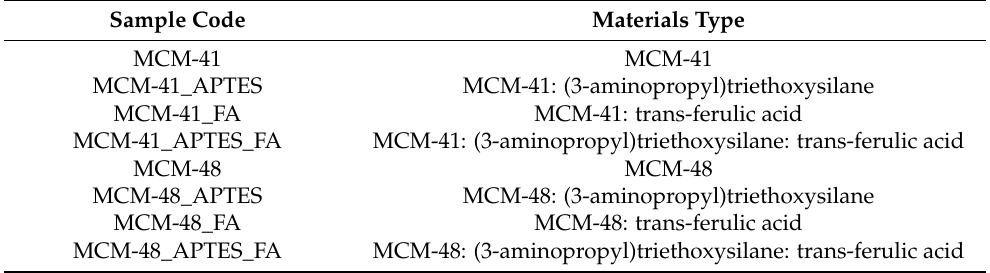
Table 1. Types of mesoporous material loaded with trans-ferulic acid